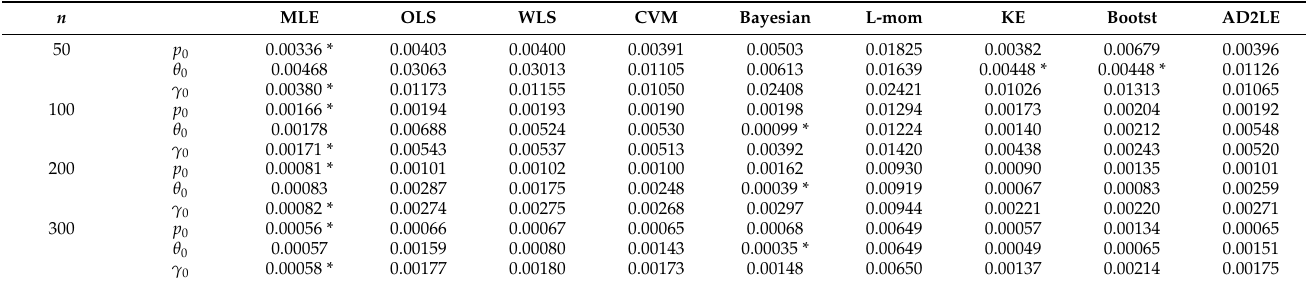
The value with “*” is the best estimation in its row for all estimation methods. Table 5. Results of the MSEs where p = 0.5, γ = 0.3, θ = 0.6.